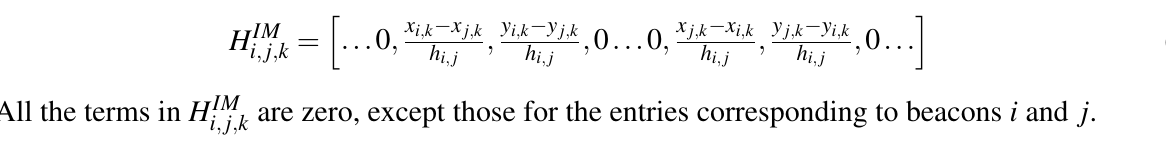
Figure 3. Diagram of the integration of inter-beacon measurements in the proposed